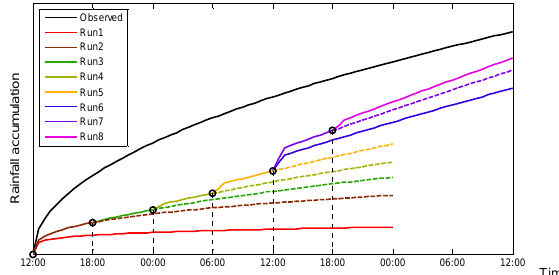
Figure 5 Presumed trends of the rainfall cumulative curves after data assimilation Fig. 5. Presumed trends of the rainfall cumulative curves after data